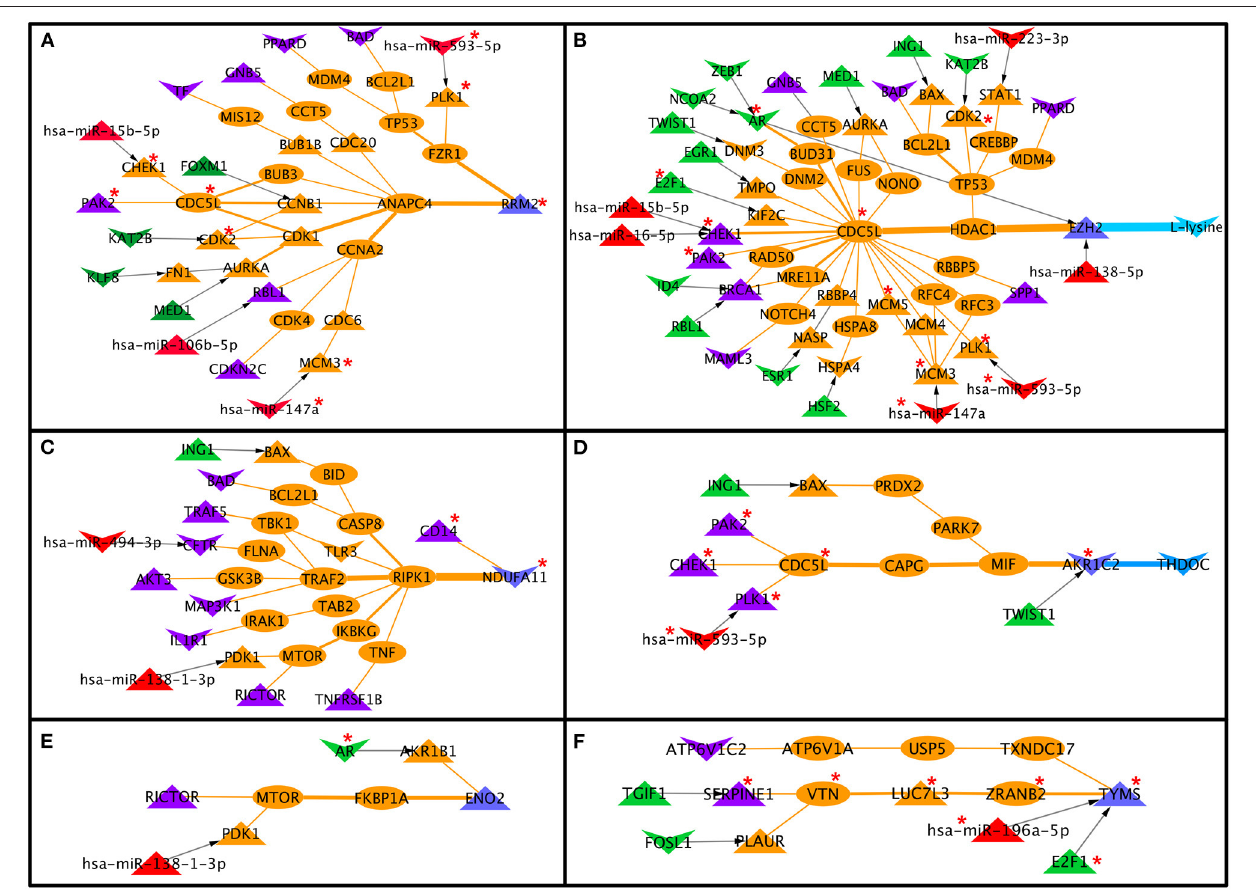
FIGURE 6 | Signaling pathway proteins, transcription factor, and miR cross-connecting paths/links to metabolic enzymes in cervical cancer. Six metabolic enzymes (A–F) are commonly linked to signaling proteins, transcription factors, and miR. Two metabolic enzymes, EZH2 and AKR1C2 (B,D) , are connected to deregulated metabolites in cervical cancer. Terminal signaling pathway proteins, transcription factors, and miRNAs, metabolic enzymes are colored in purple, green, red, and blue. Protein-protein interactors are colored in orange. Gene regulatory edges are represented as black arrows and protein-protein interactions are represented by orange edges. Nodes with an asterisk (*) are key or effector nodes in the significant paths/network.